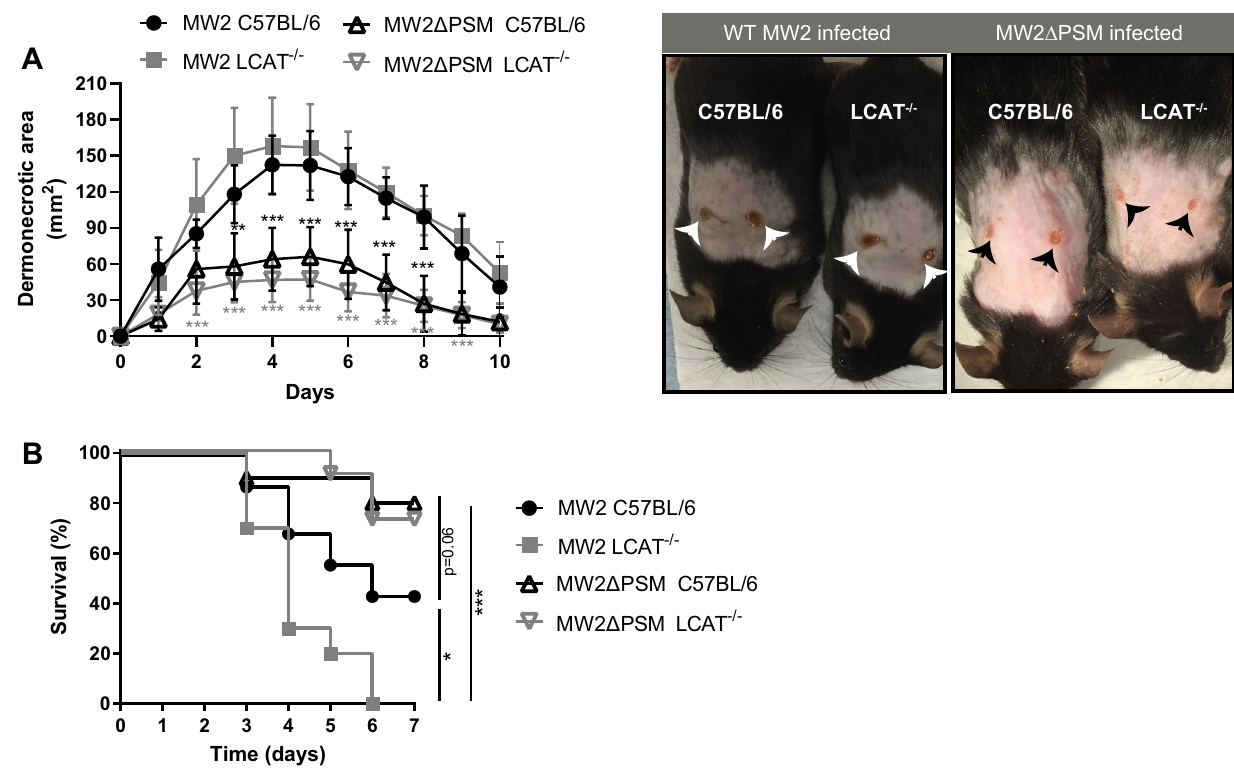
Figure 4. HDL protects against PSM mediated staphylococcal virulence during bloodstream infections, but not during skin infection. ( A ) C57Bl/6 and LCAT −/− mice were infected with S. aureus MW2 WT or MW2ΔPSM (MW2Δ α,β,hld ) by subcutaneous injection, and developing skin infection was observed. The size of dermonecrotic lesions was measured daily. Mice were infected with 5 × 10 6 CFU MRSA (n = 10 animals per group). ***, P < 0.001; **, P < 0.01; 2-way ANOVA with Bonferroni post-tests ( B ) Bacteremia model, survival curve. 8 × 10 7 CFUs of live S. aureus MW2 or isogenic MW2ΔPSM were injected into the tail veins of C57Bl/6 and LCAT −/− mice (n = 10–16 animals per group). Survival curves were monitored for statistical significance by the log-rank test*, P < 0.05 ***, P <